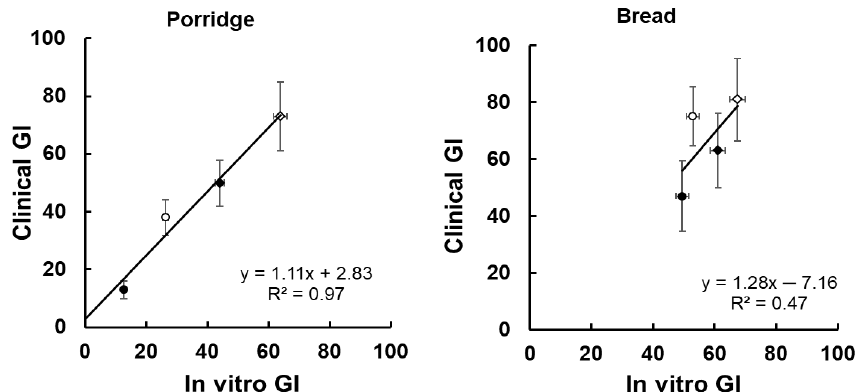
Figure 3. Correlations between GI values determined in vitro and in vivo [1,2], for porridges and bread. For clinical values (y axis) means ± SEMs are shown. For in vitro values (x-axis) error bars are analytical SDs based on average CVs of 3.5% (porridge) and 3.8% (bread). Porridges: fine cooked (◊), coarse cooked ( ♦ ), fine raw ( ○ ), coarse raw (●). Bread : roller milled flour (◊), stoneground flour ( ♦ ), kibbled grain/stone ground flour ( ○ ), intact grain/kibbled grain/stoneground flour (●). (cid:35)